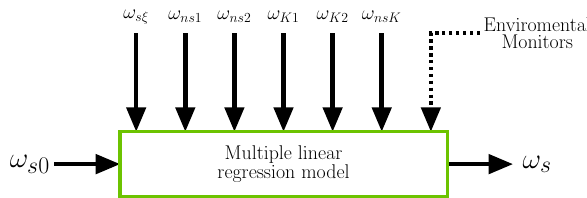
Multiple linear regression model Fig. 3 Linear regression model analysis scheme: parameters ξ , μ , and MK related to the reduction of systematics due to laser dynamics are evaluated by statistical means in order to determine ω s . Other